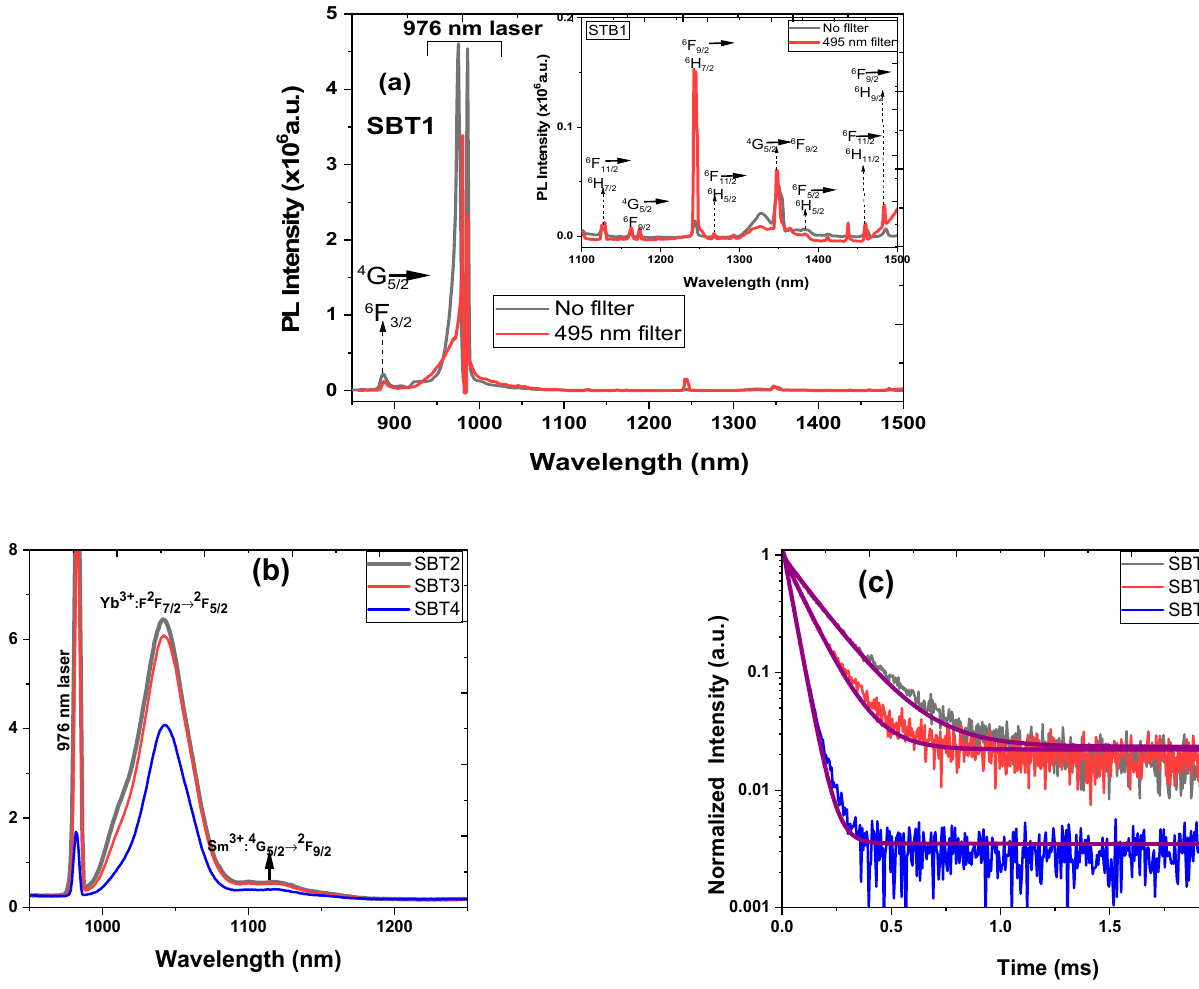
Figure 7. Near-infrared photoluminescence emission spectra of Sm-doped and Sm 3+ : Yb 3+ -codoped glasses under 978 nm excitation source: ( a ) sample SBT1 with 495 short-pass filter and without (an inset shows emission spectra from 1100 to 1500 nm), ( b ) with 450 nm filter, ( c ) photoluminescence– decay curves of different Yb 3+ content in glasses at 2 F 5/2 transition.